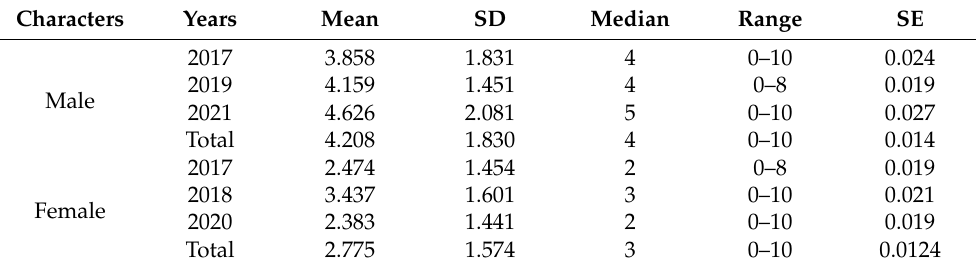
Table 2. Summary statistics (mean (M), standard deviation (SD), median, range, and standard error (SE)) of P. orientalis male and female strobili production across years ( N = 5763